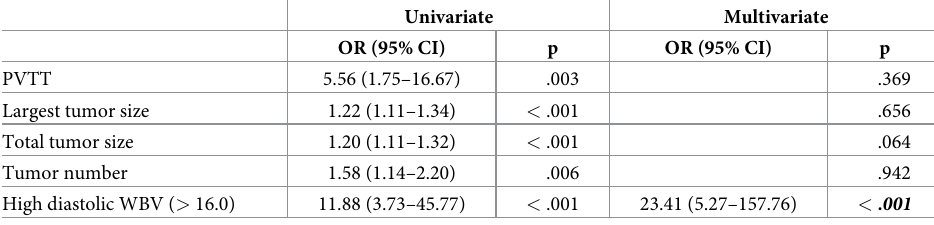
Table 2. Univariate and multivariate logistic regression analysis for factors associated with the extrahepatic